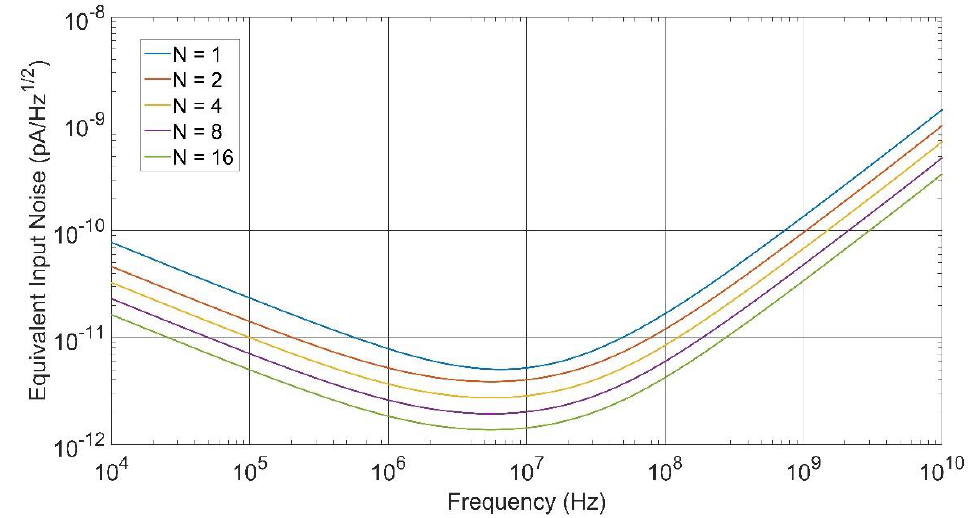
Figure 4. Input-referred noise of the front-end using the divide-and-conquer technique for different numbers of pieces.